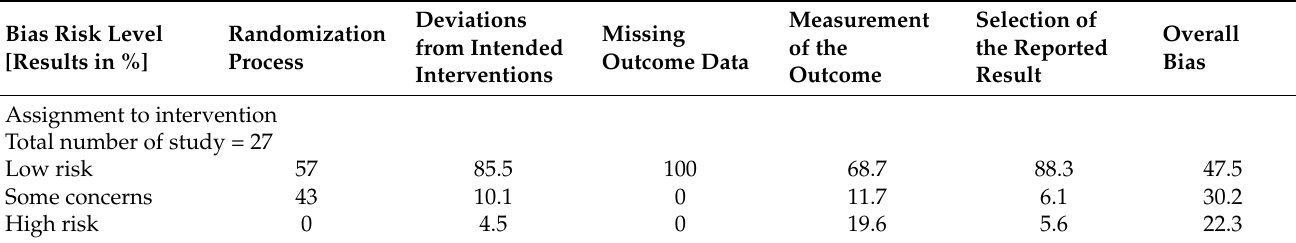
Table 2. Result of the analysis of risk of bias by dimensions.